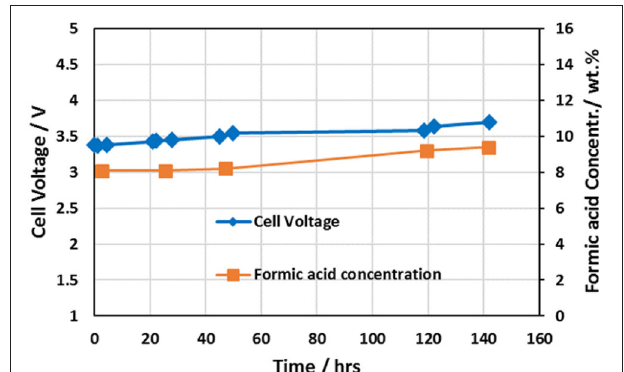
FIGURE 4 | Formic acid cell performance data for the cell configuration tabulated in Table 2 utilizing an IrO 2 catalyst coated titanium sintered fiber anode, Nafion ® 324 cation membrane, and Sustanion ® 37-50 anion exchange